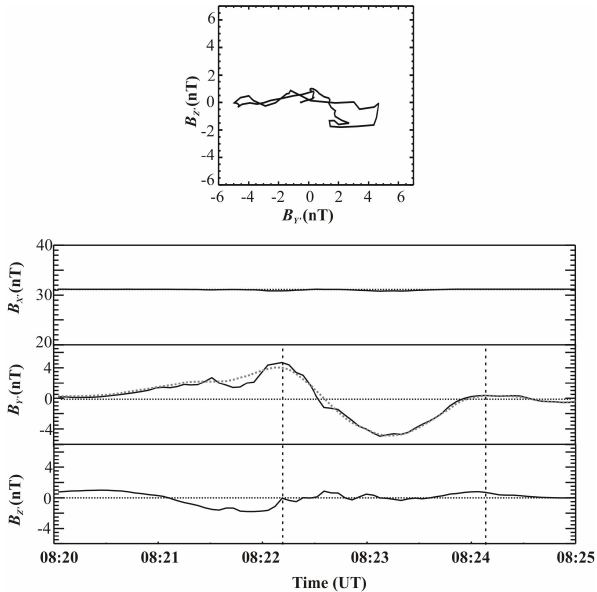
Fig. 5. Hodogram of the electric field E =− ( V × B ) deduced from the oxygen velocity (CODIF data from Cluster-1) in a plane perpen- dicular to the main component EX 0 and three components of E in the new coordinate system X 0 Y 0 Z 0 . Grey dotted line displays EZ 0 profile smoothed by the sliding average technique. Vertical dashed lines mark a period of the